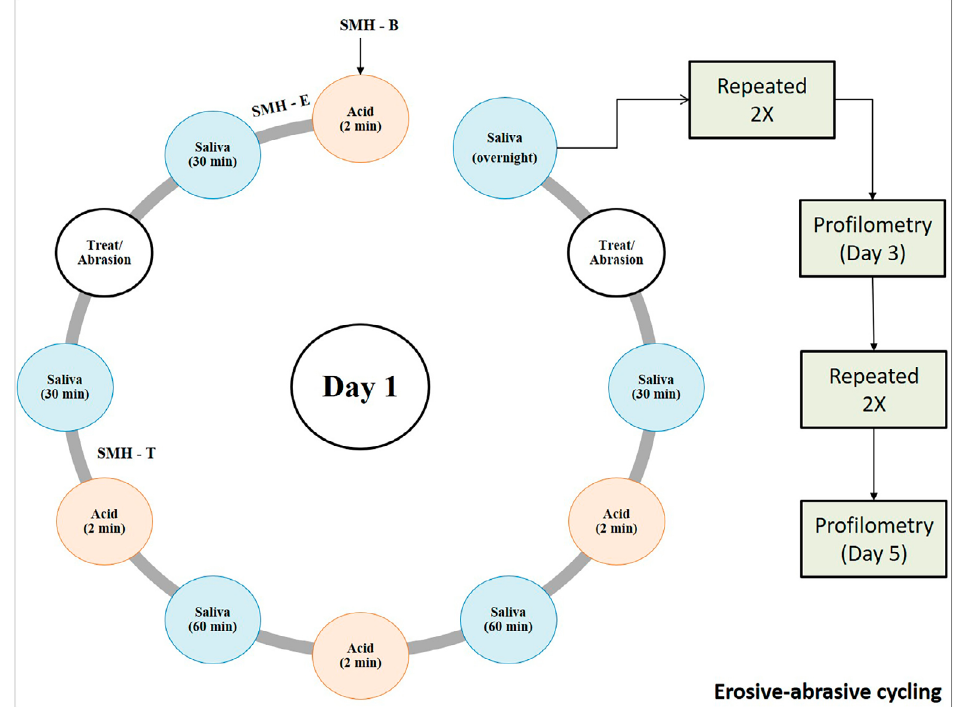
Figure 1- Daily erosive-abrasive challenges. SHM refers to the surface microhardness measurements. This was repeated for 5 days, and profilometric assay was conducted by the end of the 3rd and 5th